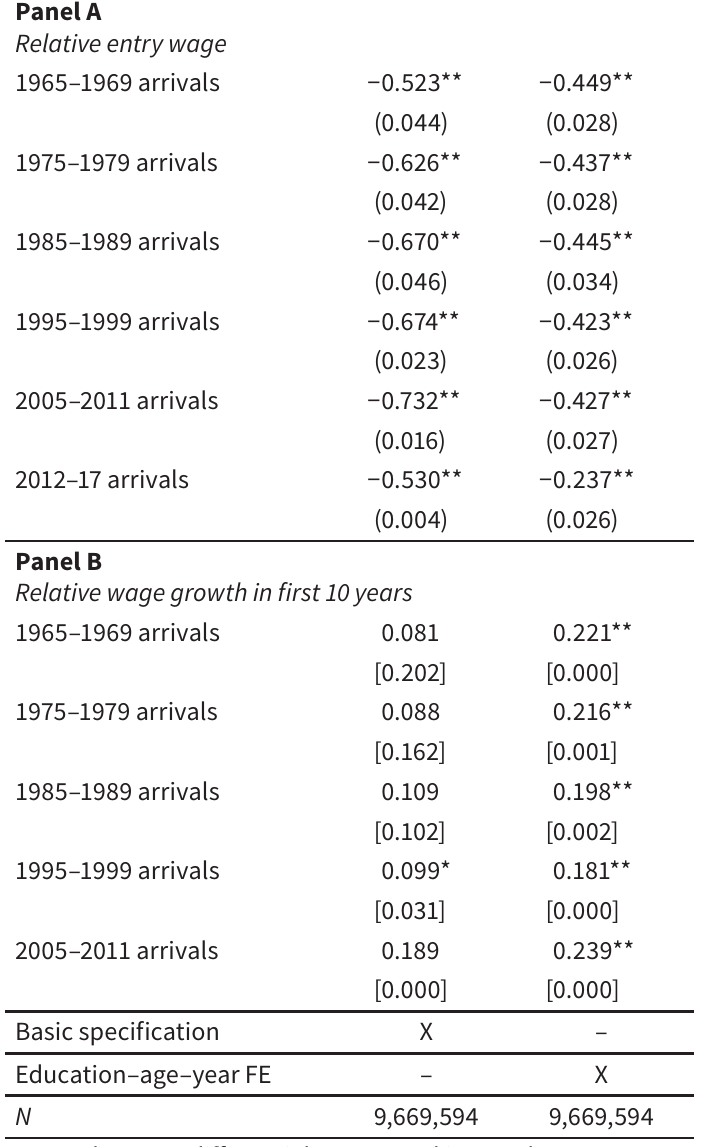
Mexican and Central American immigrants: initial gaps and convergences after first 10 years (1)